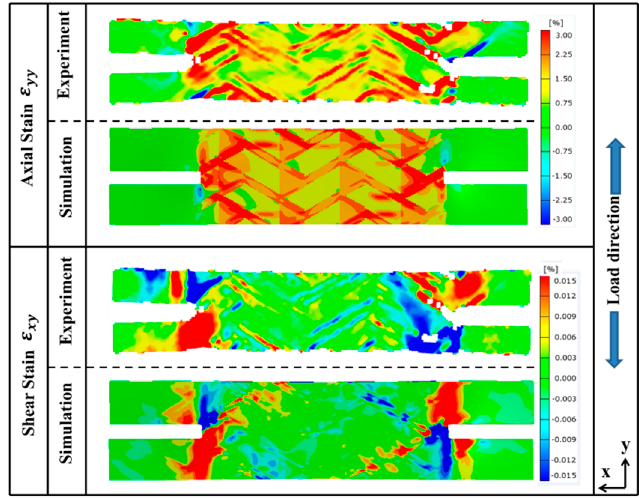
Figure 4. Comparison of numerical predicted and experimentally measured strain contours of the notched specimen under axial notched specimen under axial tension.